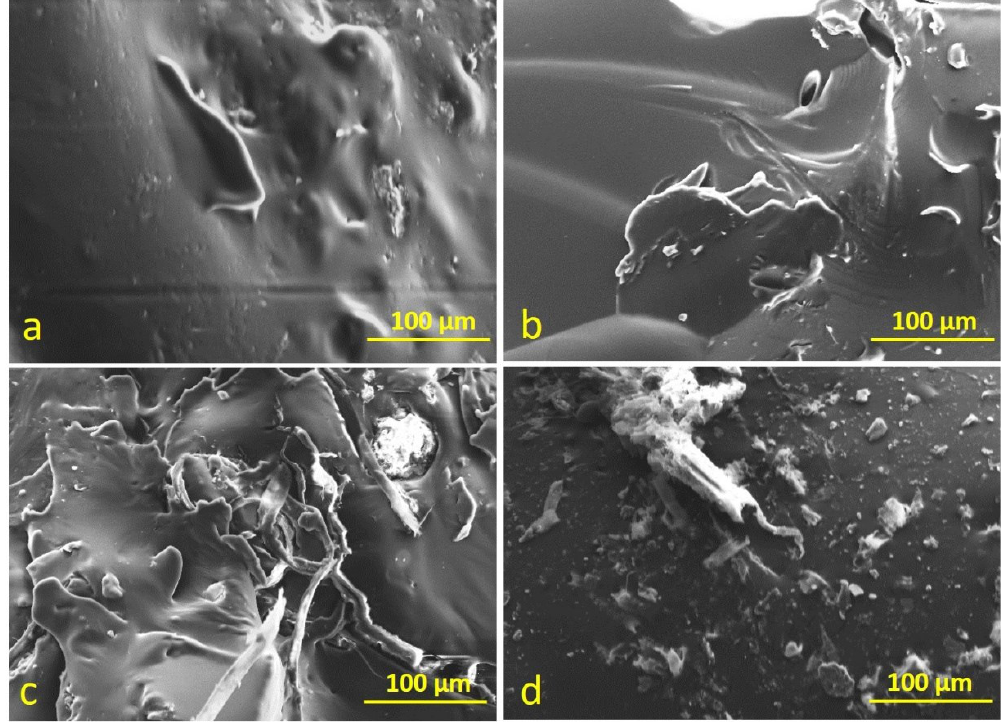
Figure 15. SEM images of bitumen specimens after RTFO- aging: ( a ) C, ( b ) 5PC, ( c ) 5PTFE, ( d ) 2.5PC- 2.5PTFE.